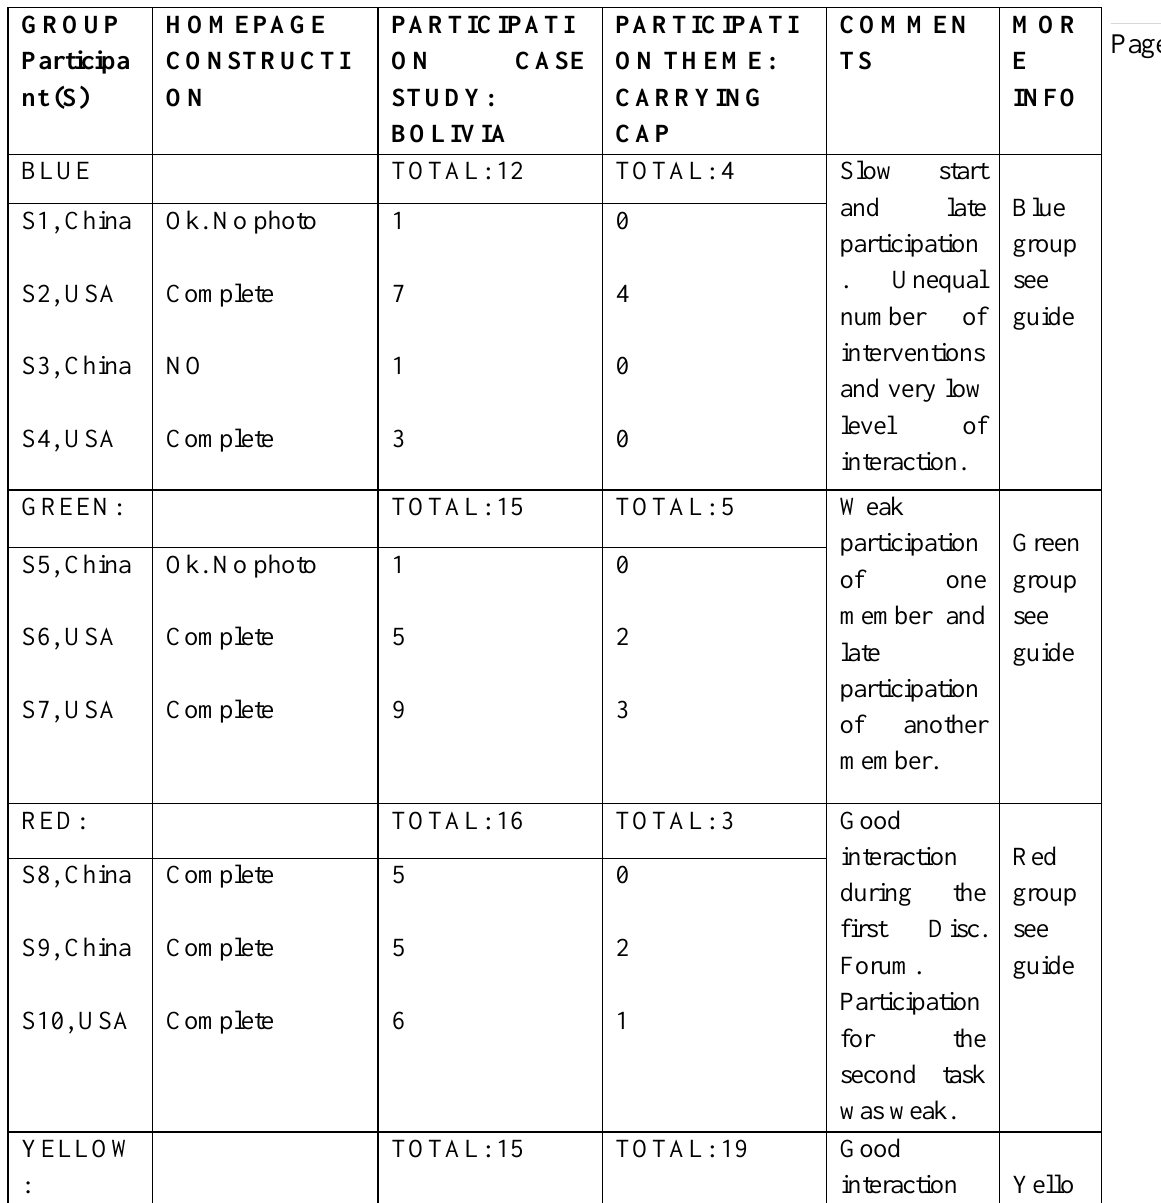
Table 2 Lesson 1: Example of guide checking the interaction level for some activities GROUP